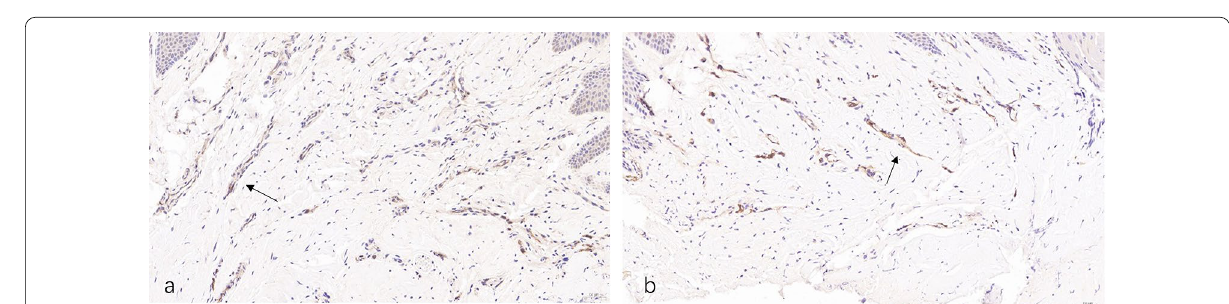
Fig. 9 Immunohistochemical staining CD31. a CGF group. b Bio-Gide group